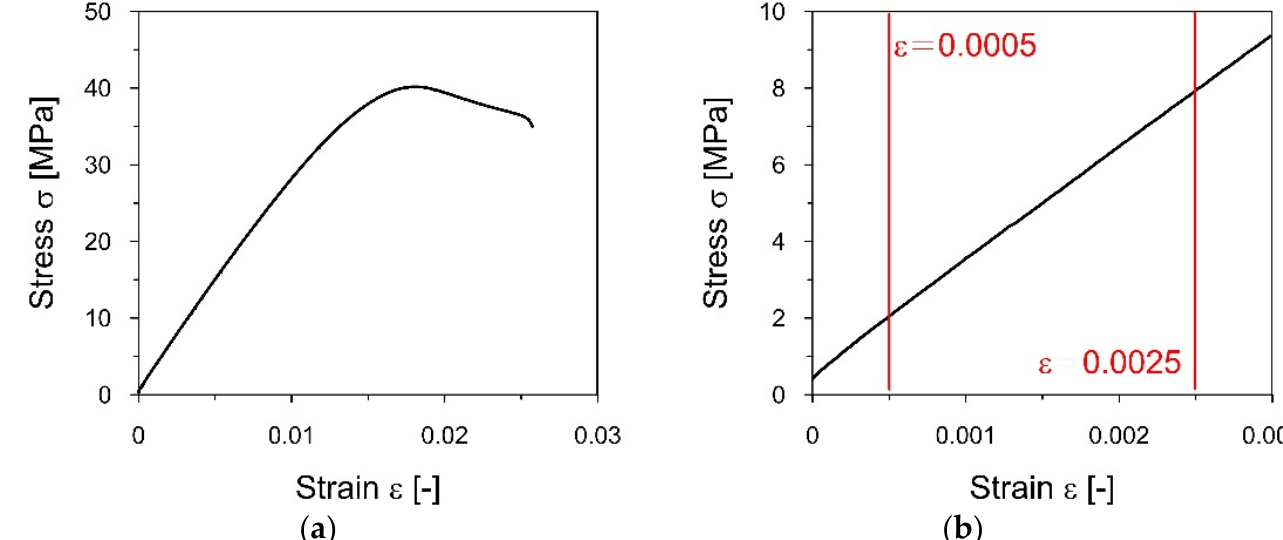
Figure 7. The strain − stress curve for the A1 specimen obtained from the tensile static test: ( a ) The whole registered experiment; ( b ) the detail of the curve used to determine the elasticity modulus.